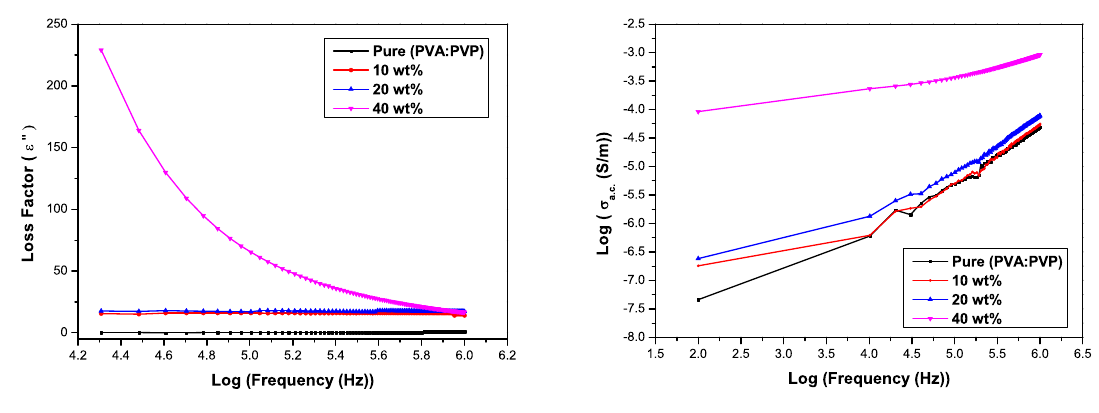
Figure 3: Semi-log plot of the loss factor as a func- tion of the frequency of pure and PVA:PVP polymer blend films reinforced with different weight ratios of CdCl 2 · H 2 O salt.